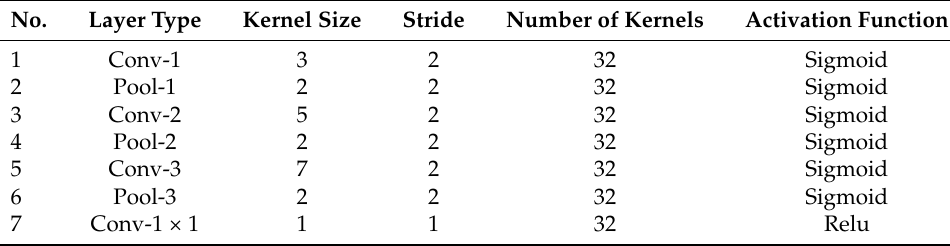
Table 1. Feature extraction module